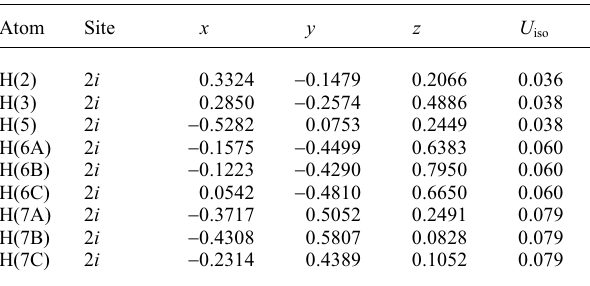
Table 2. Atomic coordinates and displacement parameters (in Å 2 )